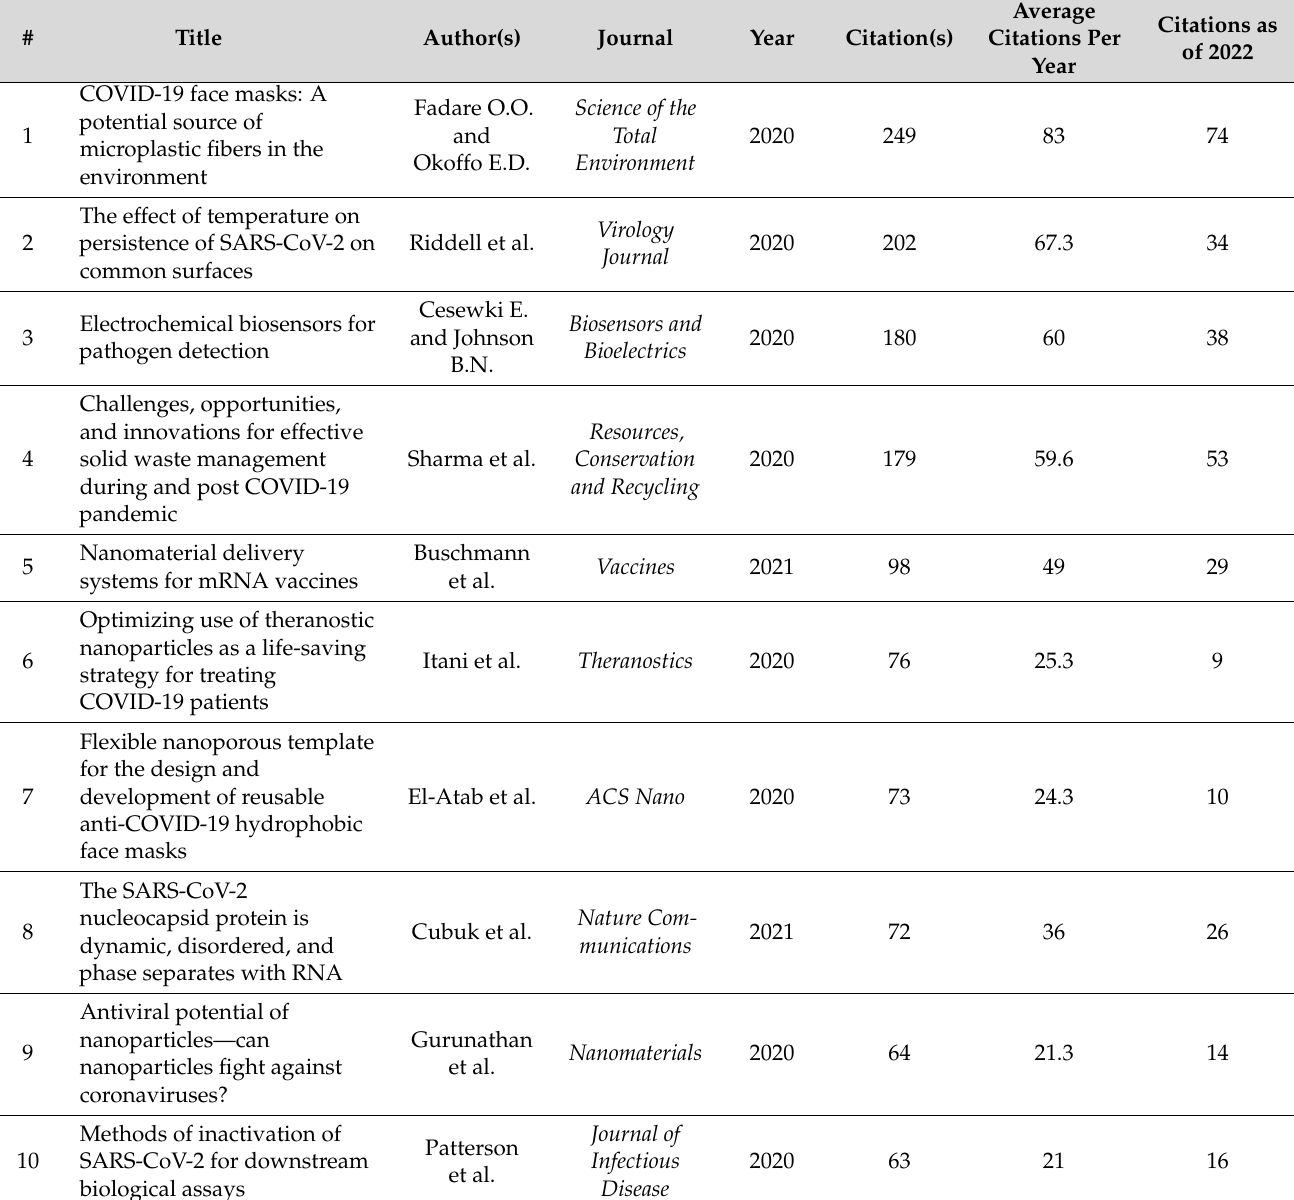
Table 4. Top 10 most cited studies on polymer technology research related to